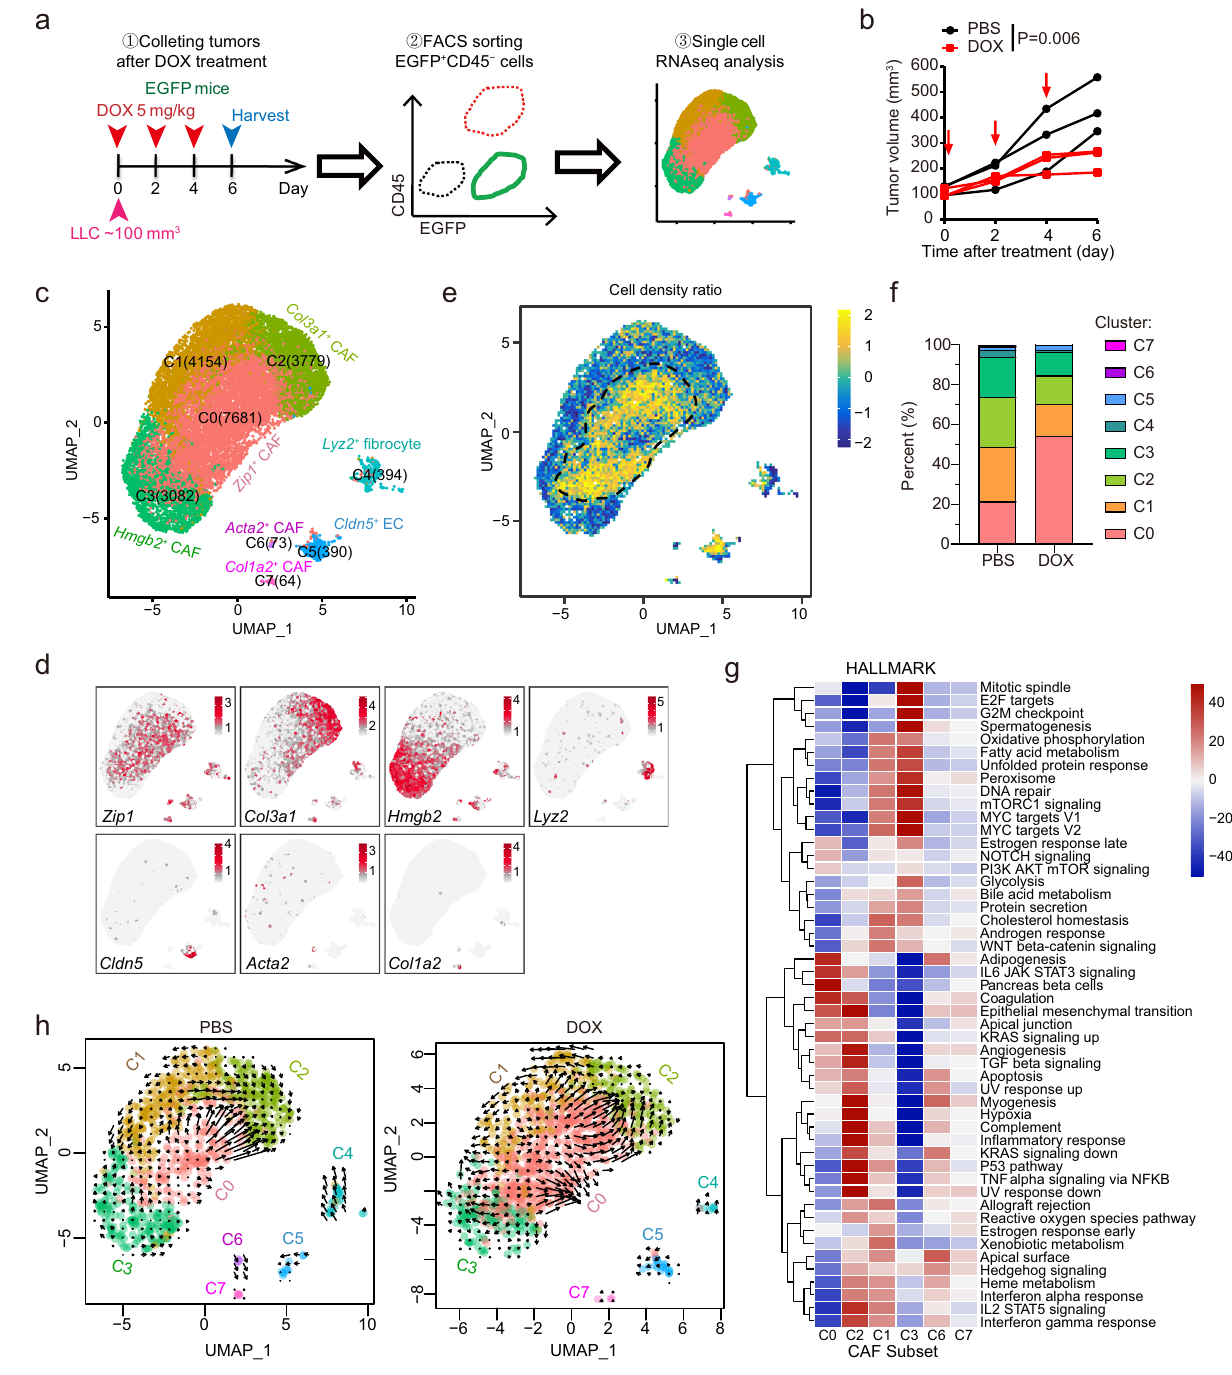
Fig. 1 | ScRNAseq reveals enrichment of Zip1 + fi broblasts in LLC tumours fol- lowing DOX treatment. a Schematic of experimental design for single-cell RNA sequencing (scRNAseq) of stromal fi broblasts after chemotherapy in LLC tumour transplanted into C57BL/6-EGFP mice. b Tumour growth curve of LLC tumours treated with or without doxorubicin (DOX) as described in a . n =3 for each group. Two-wayANOVAtestfortumourgrowthcurves. c UMAPplotdisplaying19,617cells from six mice (three treated with DOX and three PBS-treated controls), indicating